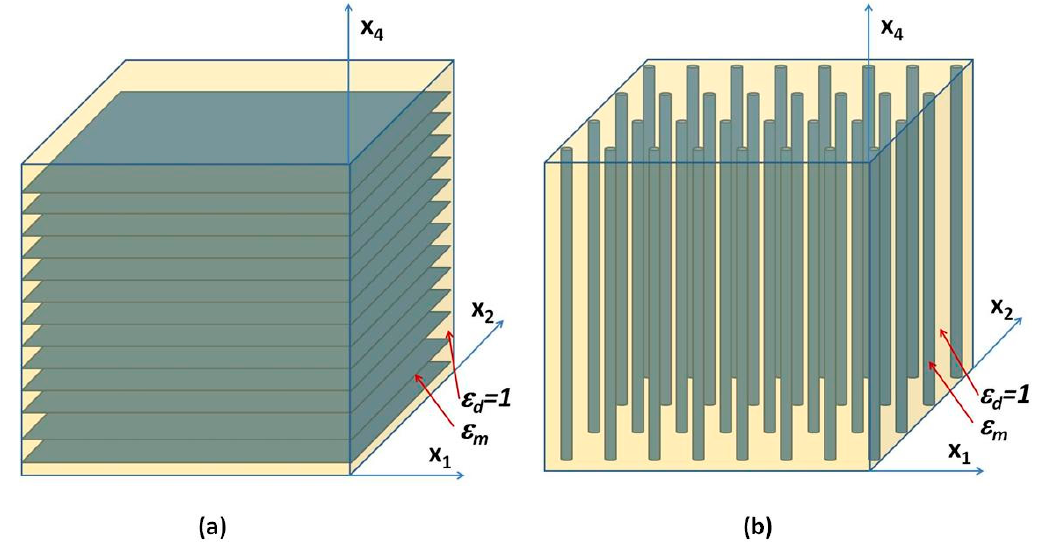
Figure 1. Lattices of topological defects in a 4 + 1 dimensional spacetime considered in our model: ( a ) Lattice of domain walls; and ( b ) Abrikosov lattice.